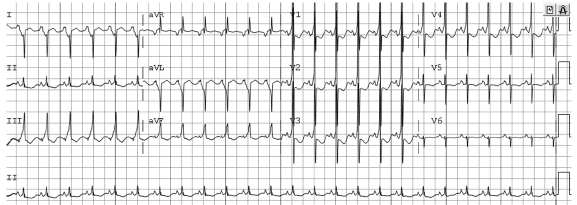
Figure 1: Initial 12-lead electrocardiogram showing sinus rhythm (HR: 150 bpm) and the ECG findings of Wol ff -Parkinson-White (WPW) syndrome.